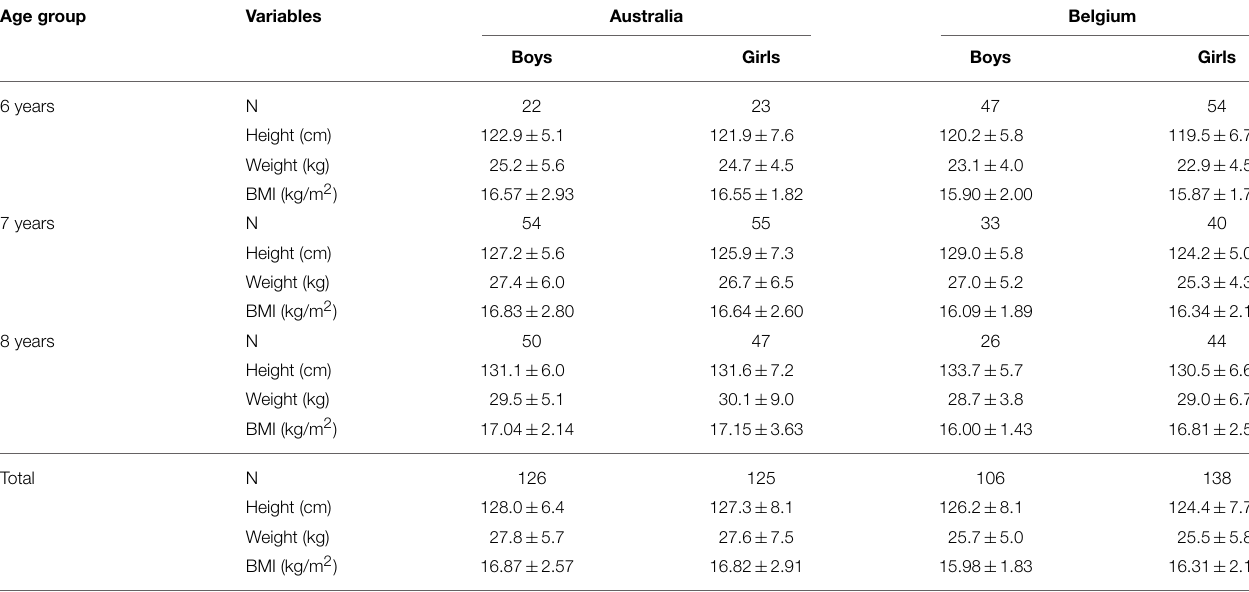
TABLE 1 | Descriptive statistics [Means and standard deviations (M ± SD)] of anthropometric measurements, stratified by age and sex.